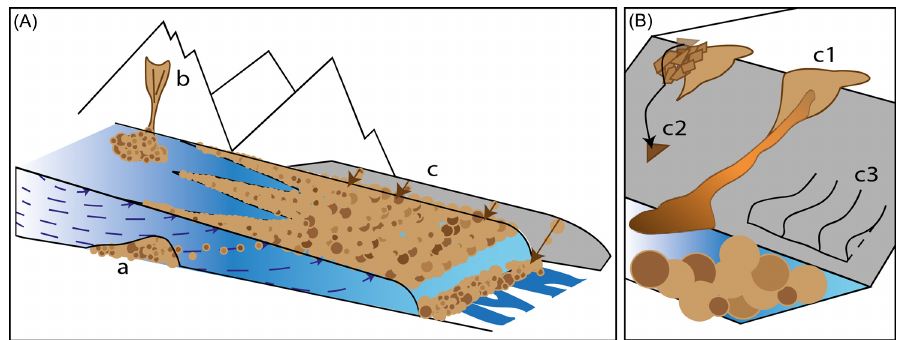
Figure 1. Schematization of debris supply processes towards the glacier surface (A) , showing basal erosion (a) , rockwall erosion (b) and sediment supply from lateral moraines (c) . Mass transport processes on a lateral moraine bordering the glacier (B) , showing debris flows (c1) , rockfall (c2) and slow slumping (partly caused by the melt of sub-moraine ice) (c3) .